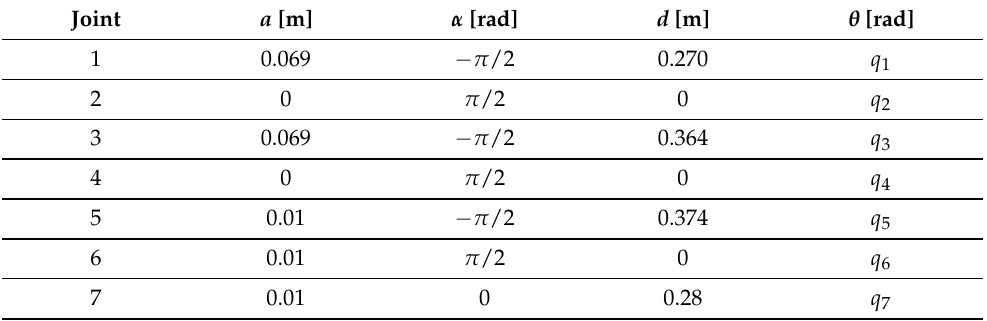
Table 3. DH table for KUKA Youbot manipulator.